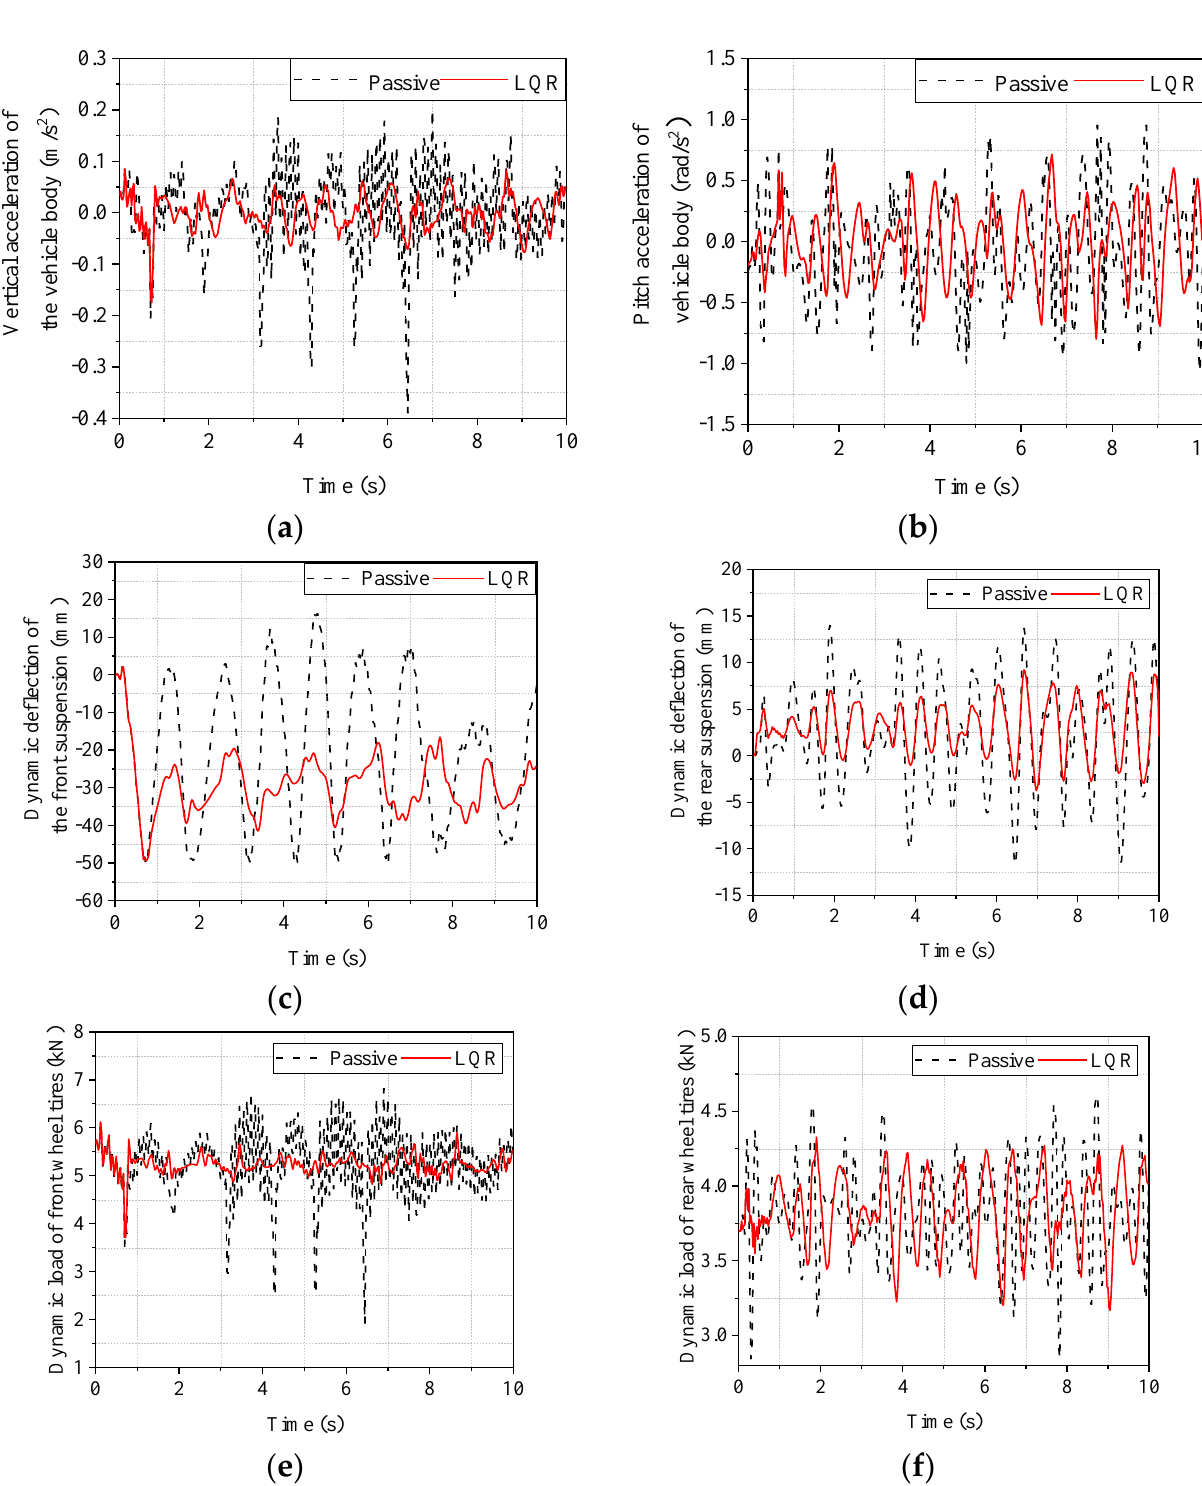
Figure 10. Simulated time domain response of high-speed conditions on Class C roads. ( a ) body vertical acceleration; ( b ) body pitch angle acceleration; ( c ) front suspension dynamic deflection; ( d ) rear suspension dynamic deflection; ( e ) front wheel tire dynamic load; ( f ) rear wheel tire dynamic load.